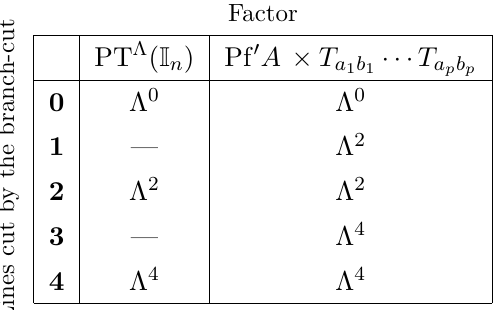
Table 1 . Λ -dependence when terms in the integrand terms are expanded around Λ = 0 . Empty entries mean that such terms do not